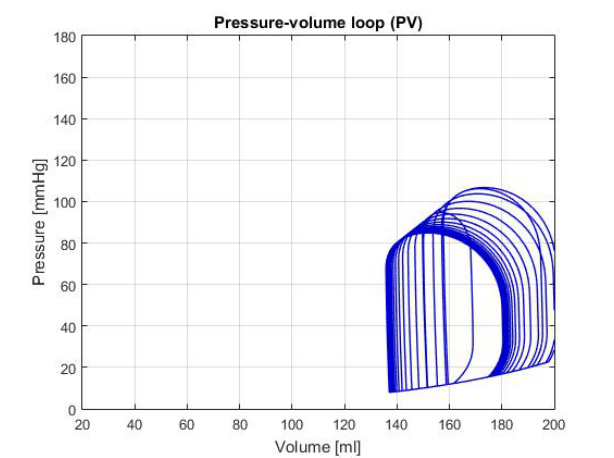
Figure 5. Graph of P-V loop curves with Systolic Heart Failure (SHF).